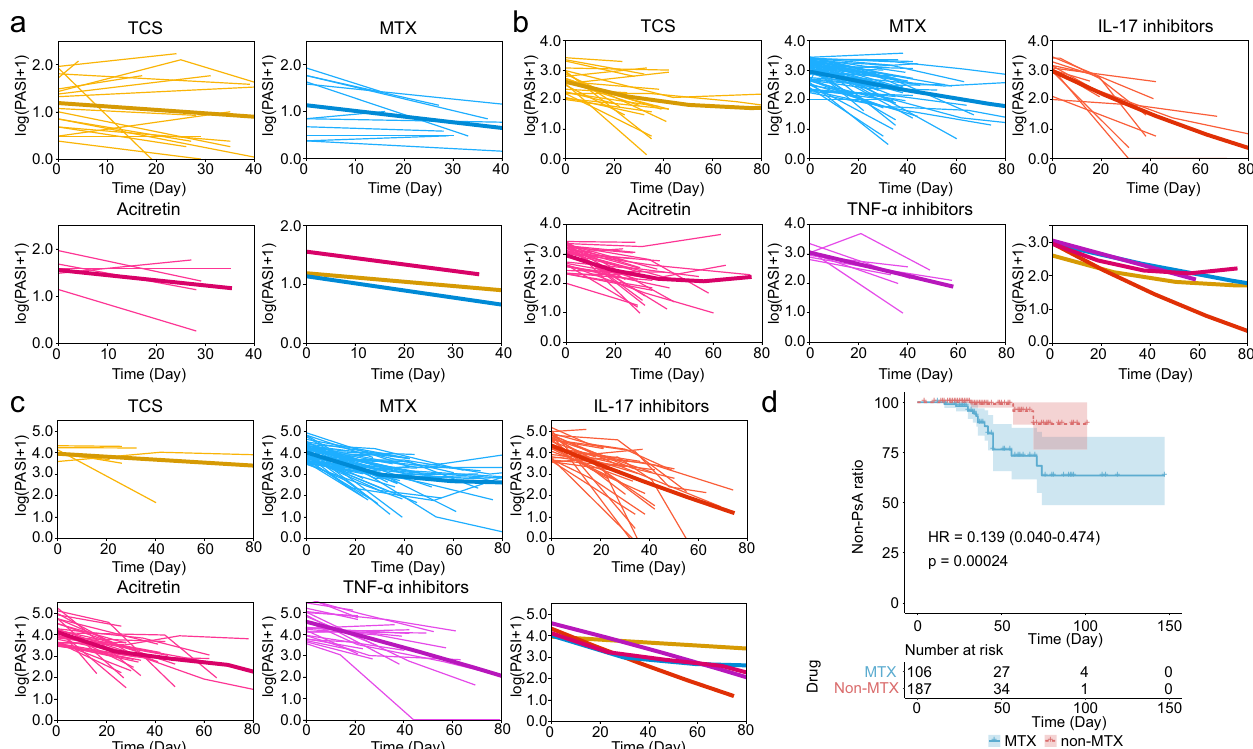
Fig. 5 Ef fi cacy comparison and analysis of different drugs for decreasing PASI values and inhibiting PsA progression. The logarithm of (PASI + 1) vs . time fi tting curves of different drugs for those patients with mild psoriasis (PASI < 3) a , moderate psoriasis (3 ≤ PASI < 10) b , and severe psoriasis (PASI ≥ 10) c . The last subplots of a – c show the comparison of fi tting curves of different drugs. d The Kaplan – Meier (KM) curve of the non-MTX drug group and MTX drug group. The p -value is obtained by the Log-Rank Test. TCS topical corticosteroid. MTX